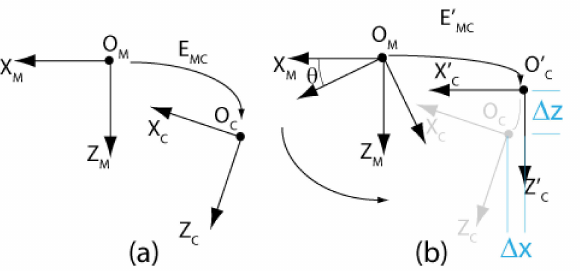
Figure 10. Transform E MC between the manipulator and the center of the camera ( a ). When the manipulator rotates around axis O M , the camera rotates and translates by ∆ x and ∆ z , which causes errors in the estimation of 3D coordinates from stereo ( b ). The translation is very difficult to estimate using standard calibration